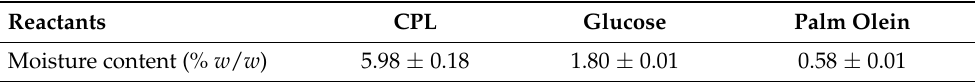
Table 4. Moisture content of reactants and lipase for glucose palm oleate green